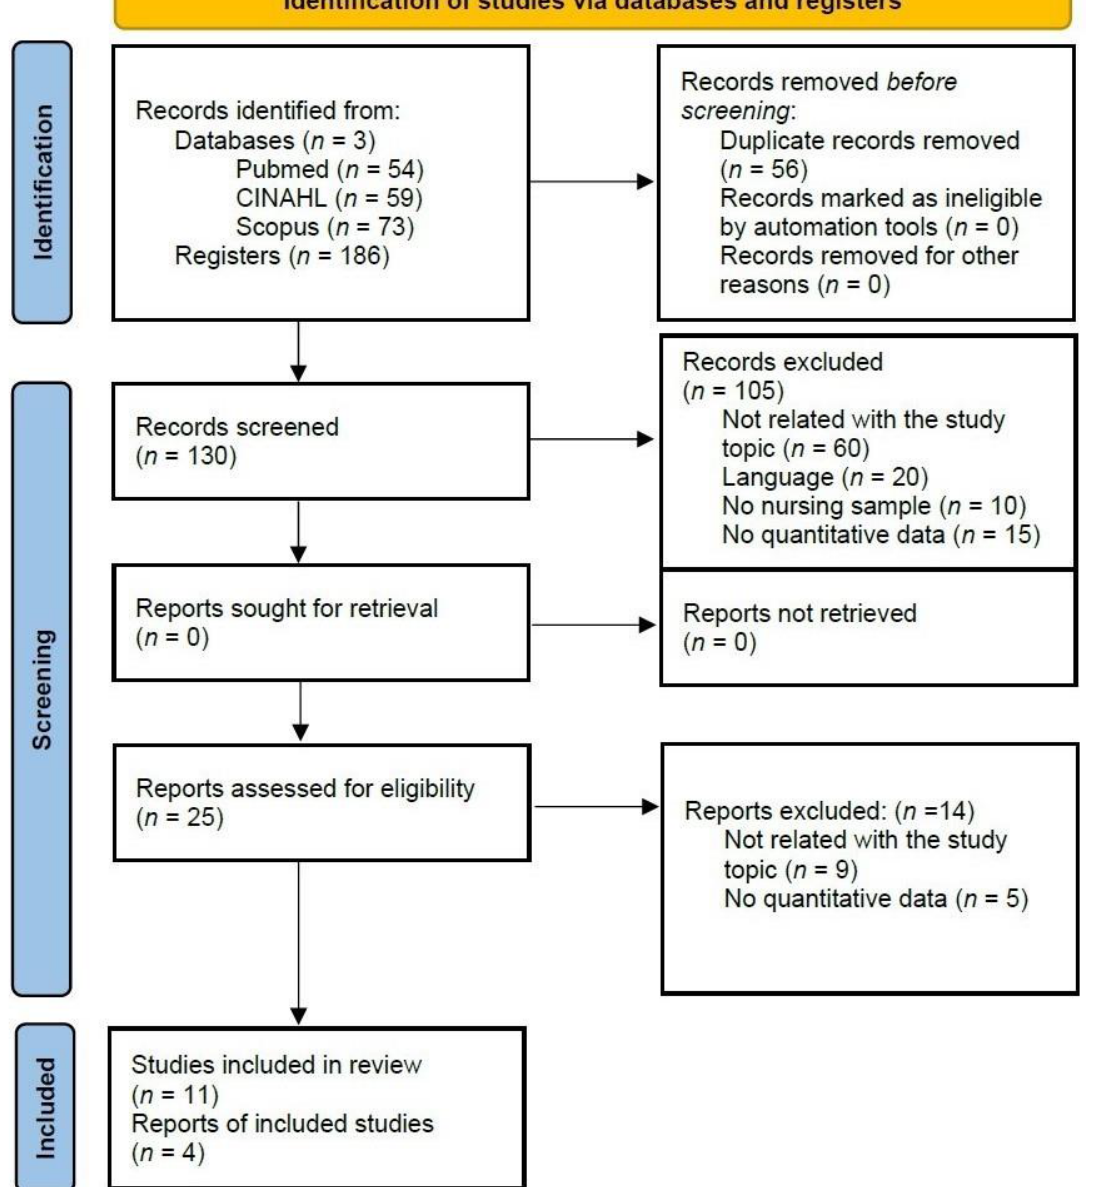
Figure 1. Flow diagram of search process.